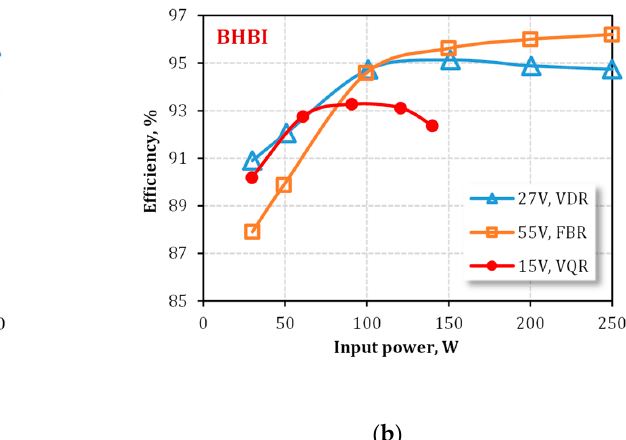
Figure 13. Closed-loop operation of the converter with BHBI. 5. Power Loss Breakdown The methodology for the power loss calculations is described in this section along with a power loss breakdown example. The power losses in the inductors includes the copper losses, dc and ac, represented by an equivalent resistance r Li . Considering the equivalent resistance and the rms current I Li,rms , the power losses in i -th inductor are calculated by: 2 , = Li Li Li rms P r I .